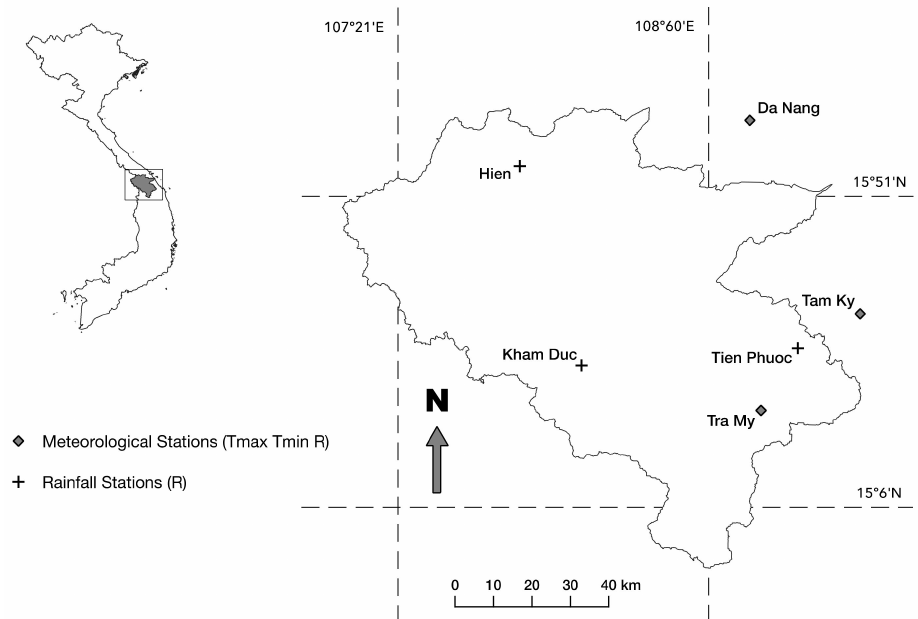
Figure 1. Geographical location of the Vu Gia Thu Bon river basin. Tmax, Tmin, and R stand for maximum and minimum temperature and